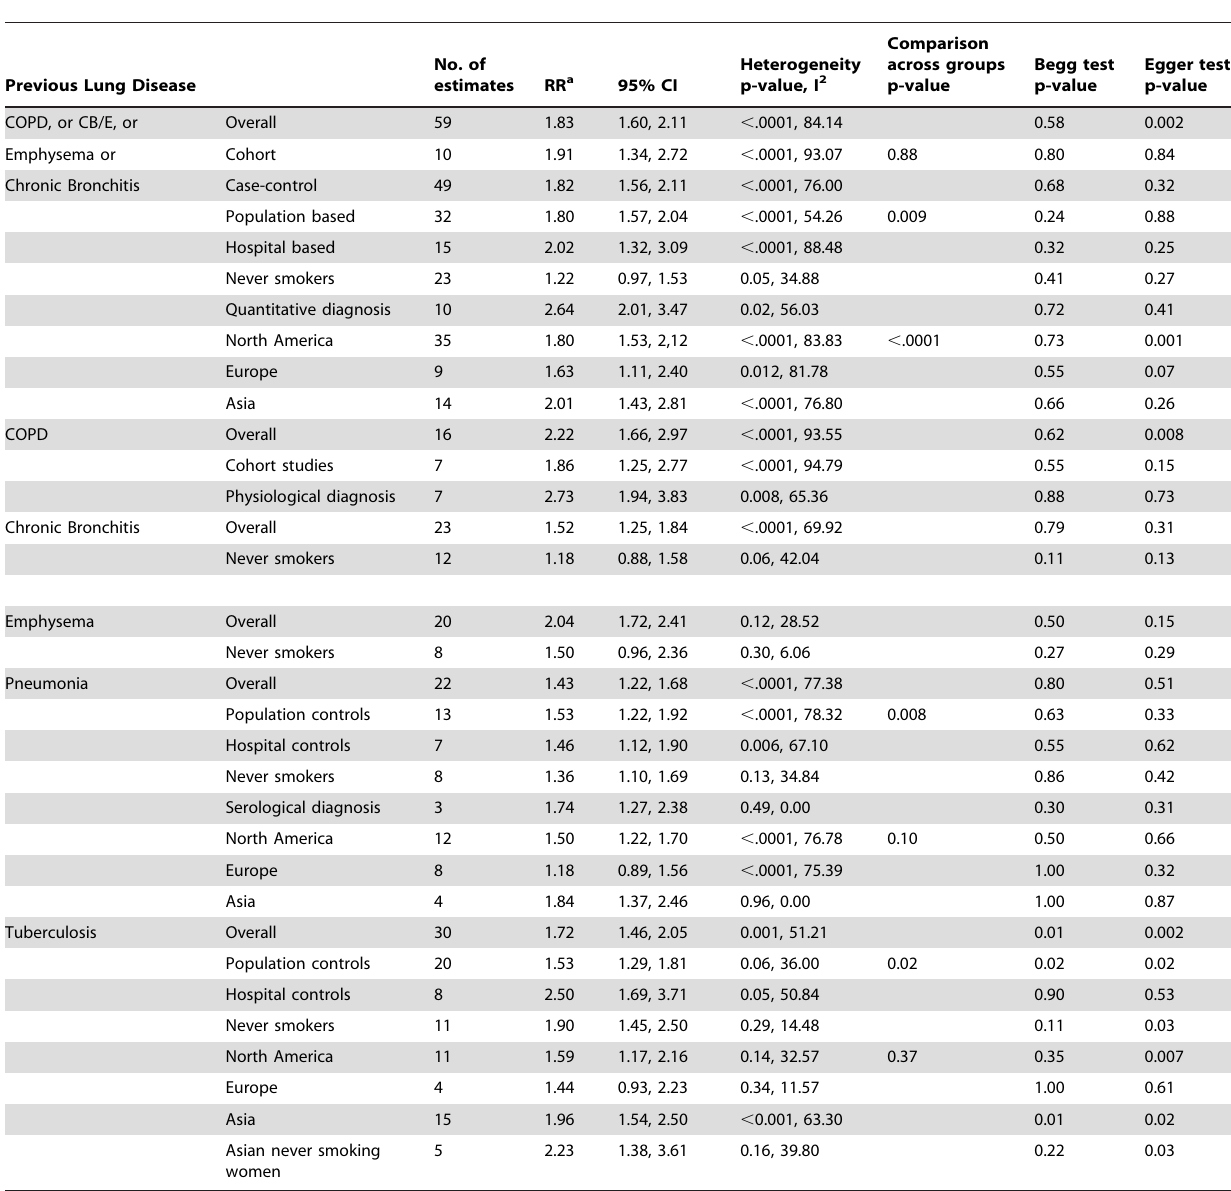
Table 1. Results of the meta-analyses of previous lung diseases overall, by condition, study design/control type and among never smoking